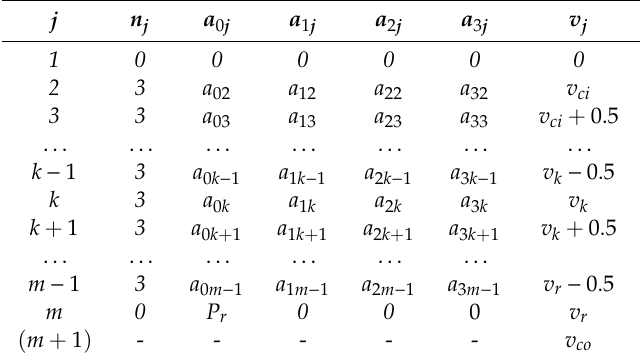
Table 4. Relationship among parameters of the CM and the parameters of the WT.